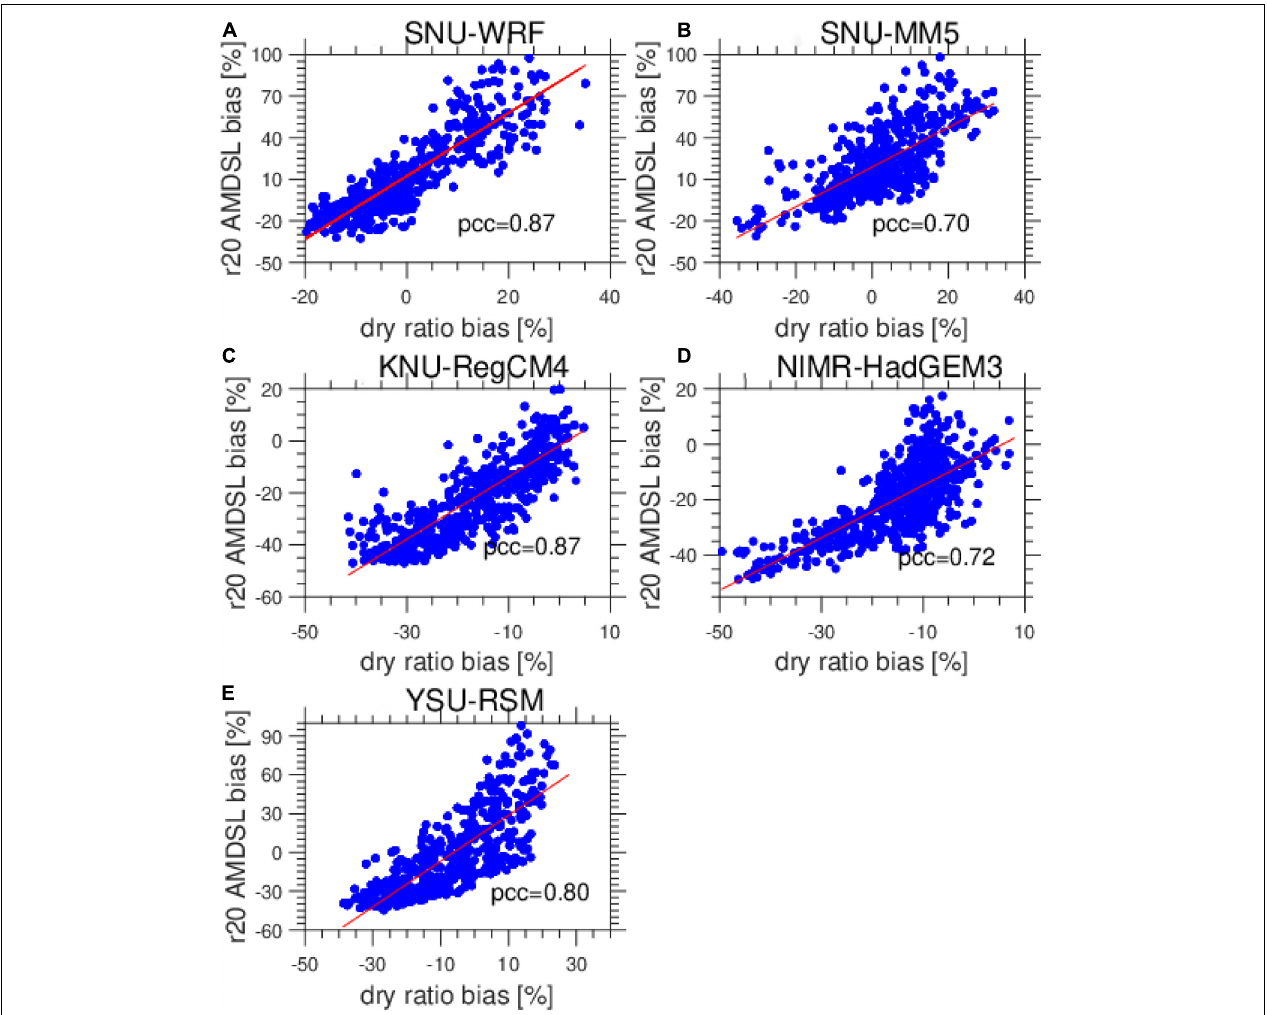
Supplementary Figure S1 . Since both scale parameter α and location parameter ξ in GEV fitting contribute to the estimation of the 20-year return value, further analysis of model ability in simulating individual GEV parameters is needed for assessment of RCM